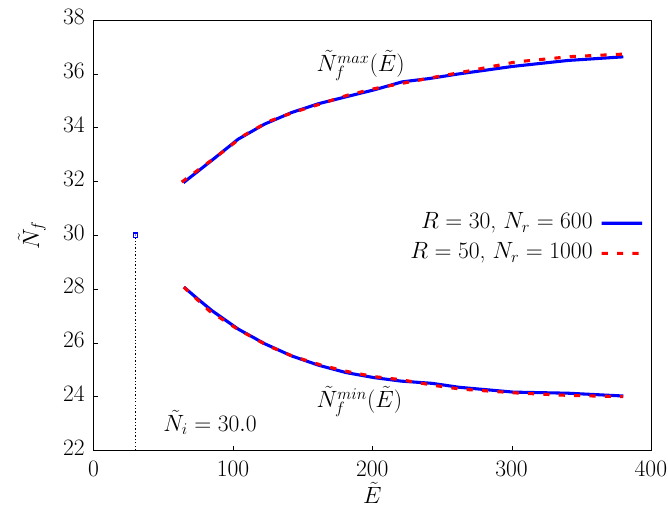
Figure 16 . The classically allowed region in the ( ~ E; ~ N f ) plane for ~ N i = 30 : 0. The lattice parame- ters are R = 30 ; N r = 600 (solid blue line) and R = 50 ; N r = 1000 (dashed red line).